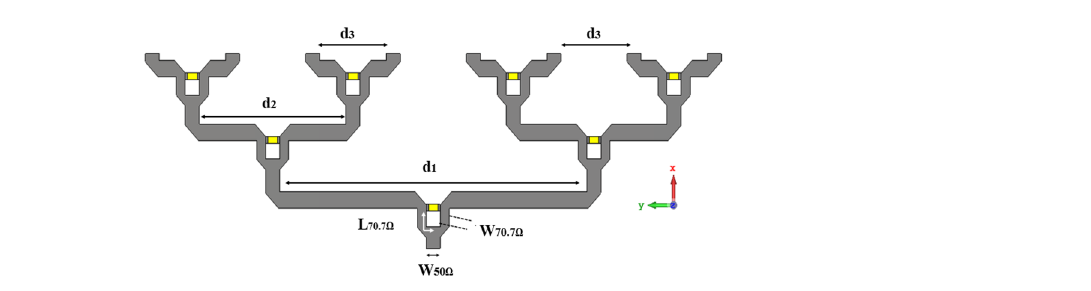
Figure 2. Eight way Wilkinson power